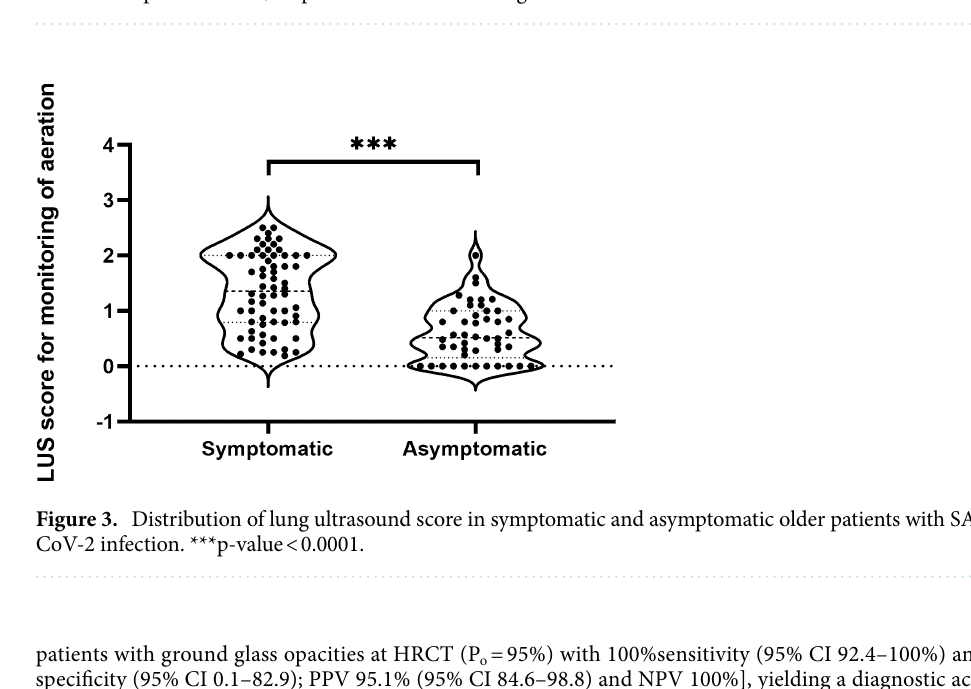
Figure 2. Lung ultrasound features of symptomatic and asymptomatic older patients with SARS-CoV2- infection. **p-value < 0.01, ***p-value < 0.001. ns not significant.